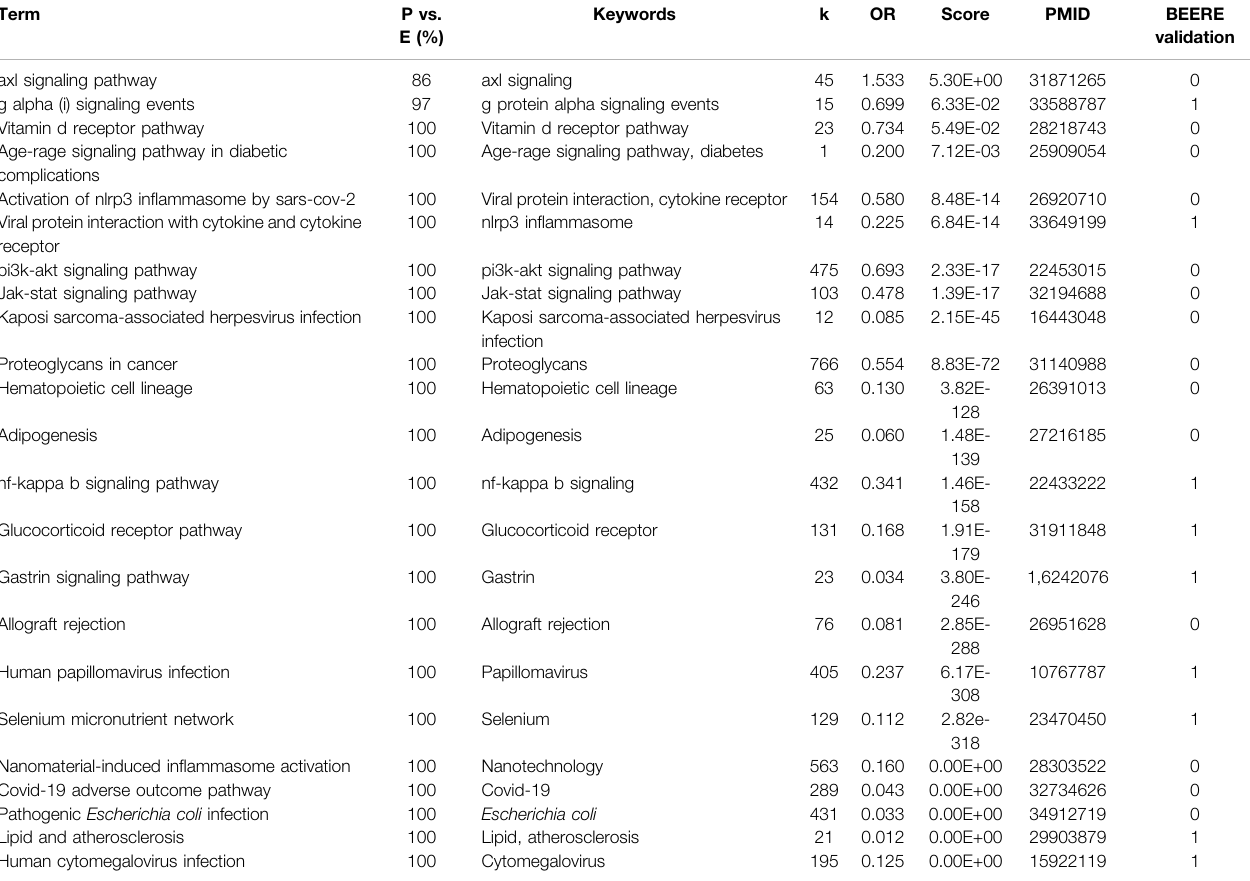
TABLE 3 | The 23 consensus pathways between PAGER, EnrichR results with PubMed literature support. Term